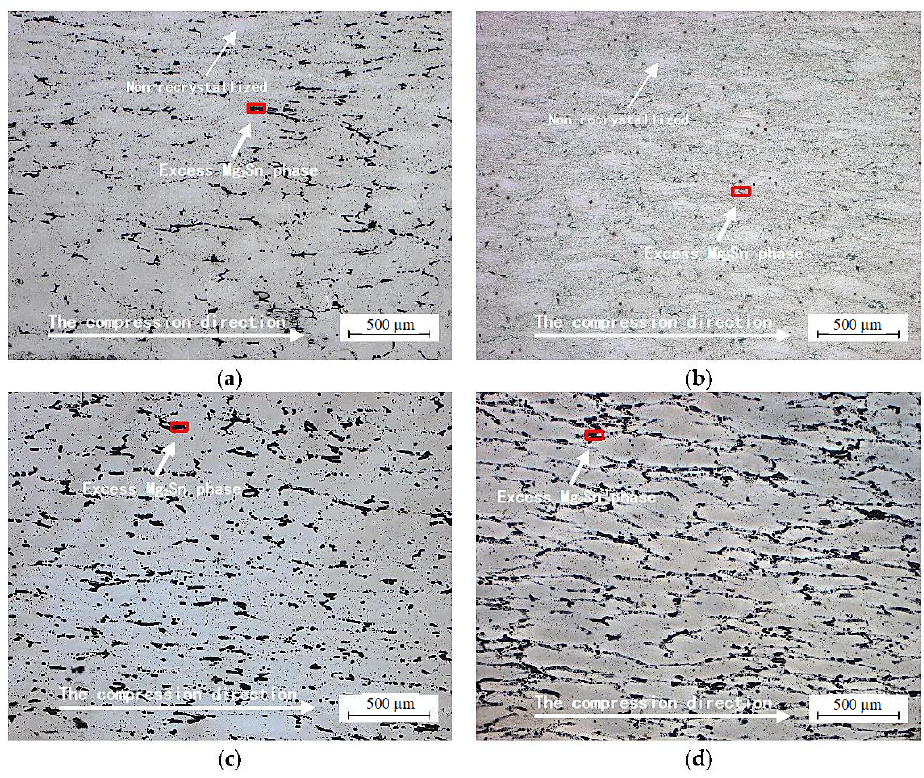
Figure 6 . Microstructures of the alloy during hot compression at the strain rate of 0.001 s −1 . ( a ) 653 K; ( b ) 693 K; ( c ) 733 K; ( d ) 773 K.